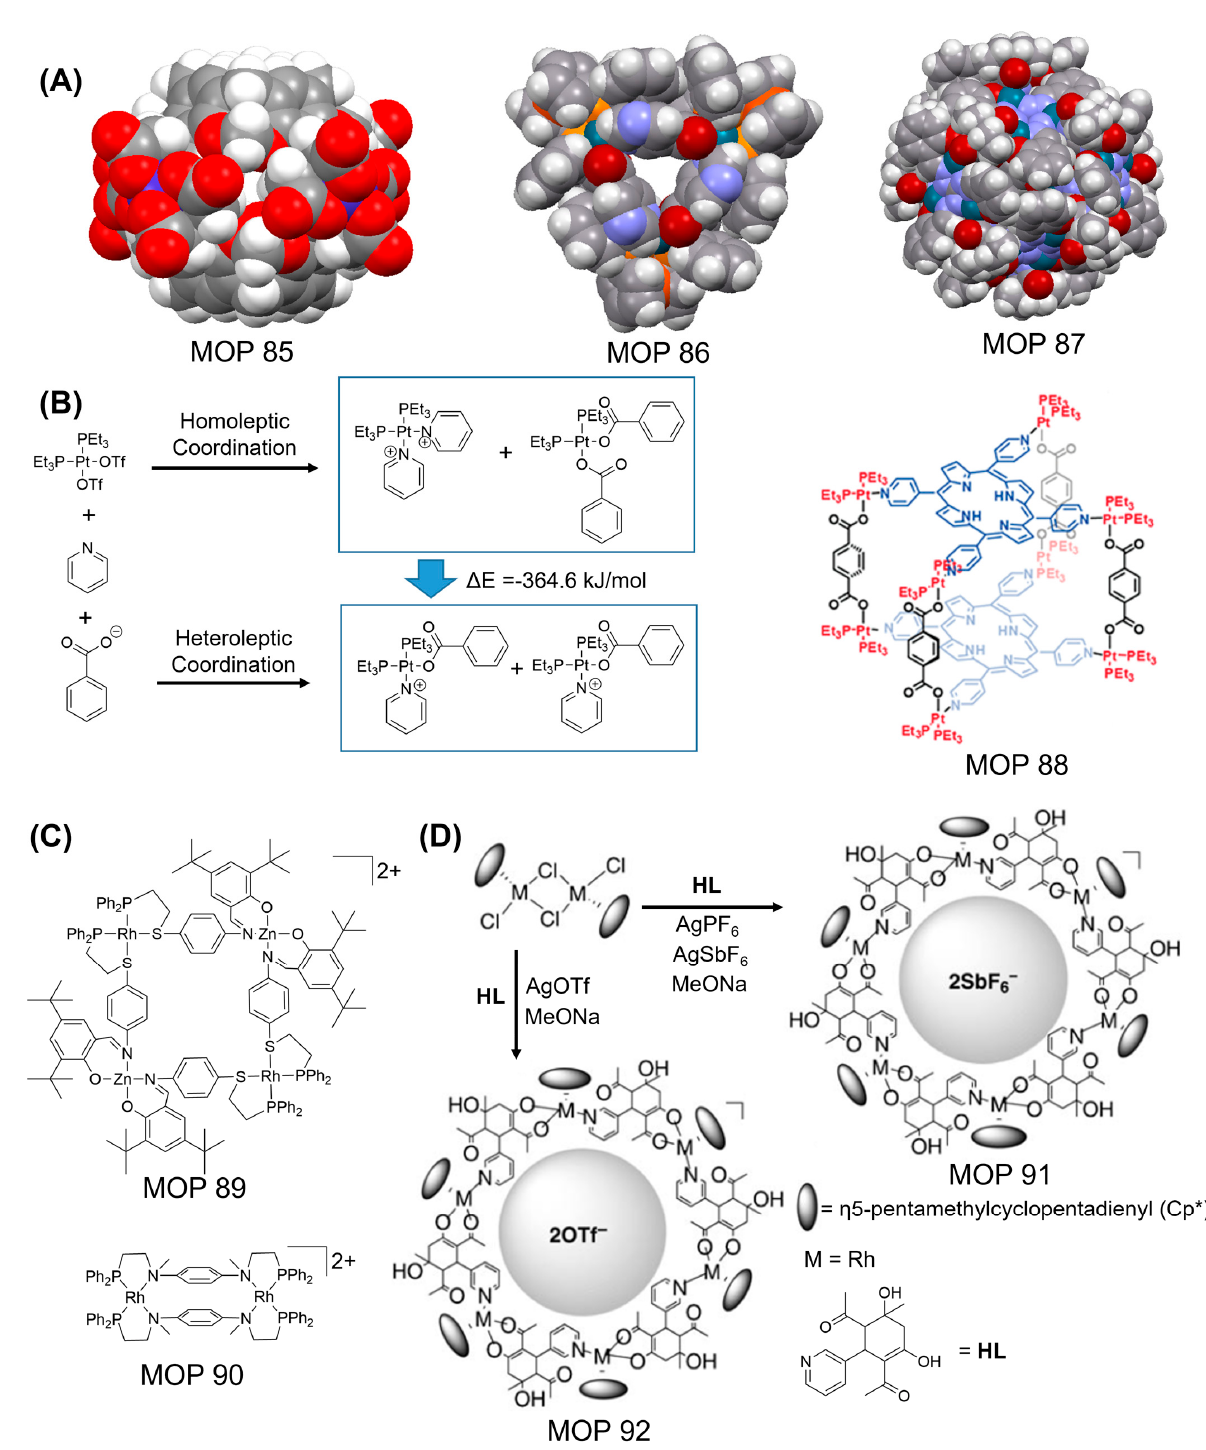
Figure 28. ( A ) Space-filling model of X-ray crystal structures of MOP 85, MOP 86 and MOP 87. ( B ) Selective self-assembly of cis -Pt(PEt 3 ) 2 (OTf) 2 with carboxylate and pyridyl moieties due to low energy of the heteroleptic coordination pathway. Chemical structure of tetragonal prism MOP 88. ( C ) Chemical structures of mixed donor atoms containing polygons MOP 89 and MOP 90. ( D ) Templated synthesis of mixed donor atoms bearing polygons MOP 91 and MOP 92. Reprinted by permission form refs. [64,216–218,222]. Copyright 1998 and 2010 from American Chemical Society. Copyright 2009 from Royal Society of Chemistry. Copyright 2004 and 2011 from